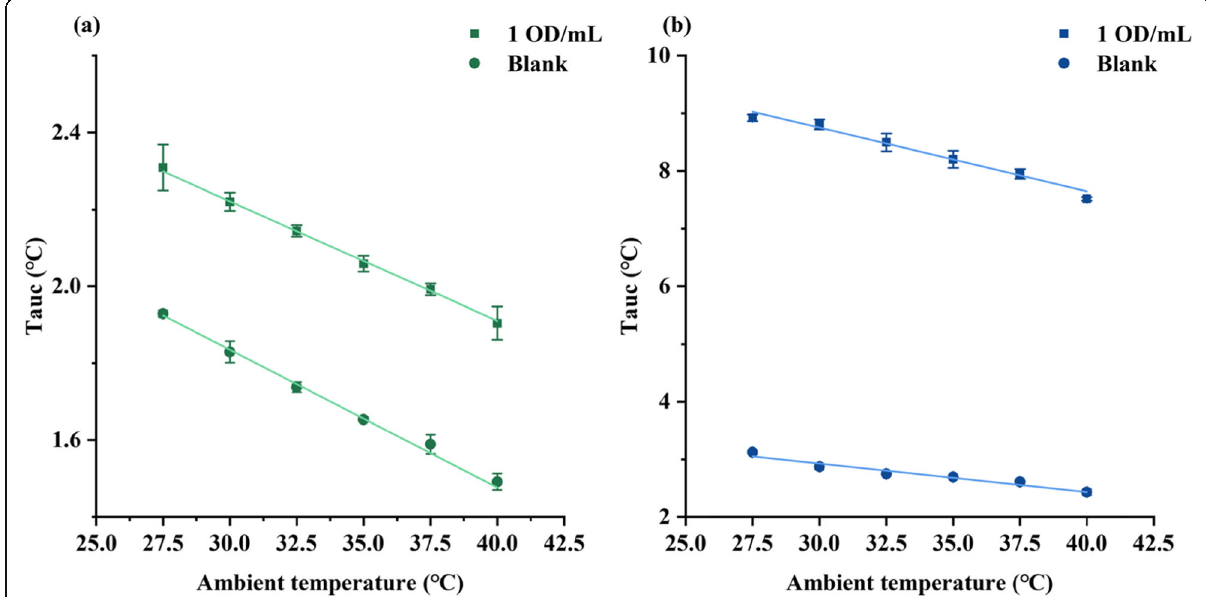
Fig. 4 Effect of ambient temperature. a Thermal signal changes with ambient temperature in conduction mode. b Thermal signal changes with ambient temperature in radiation mode